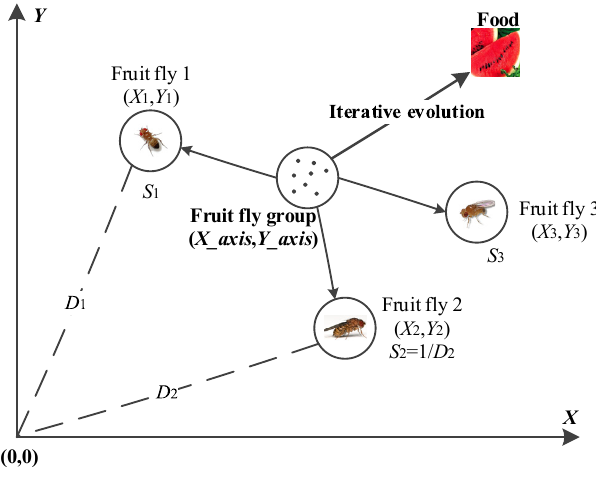
Figure 2. Fruit fly optimization algorithm.